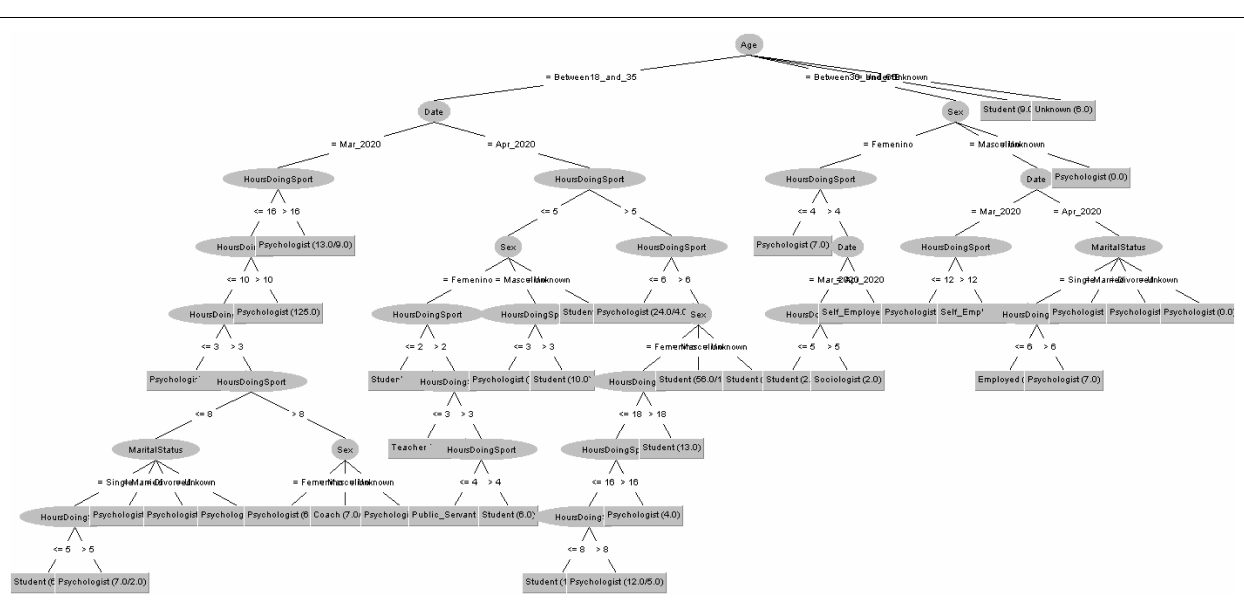
FIGURE 14 | Profession of people taking the IPED questionnaire in 2020 decision